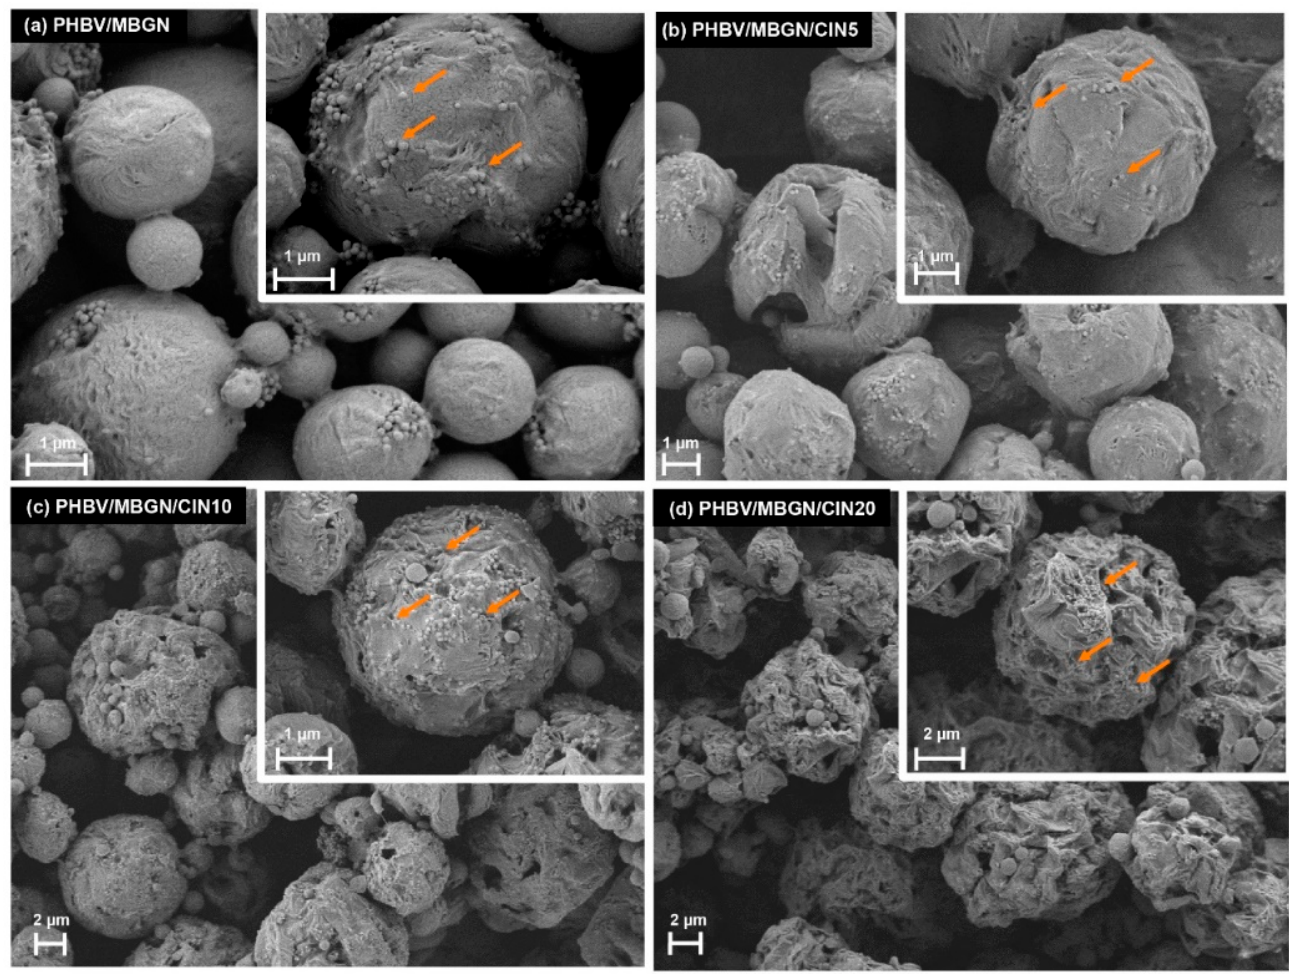
Figure 1. Scanning electron micrographs of ( a ) PHBV/MBGN; ( b ) PHBV/MBGN/CIN5; ( c ) PHBV/MBGN/CIN10, and ( d ) PHBV/MBGN/CIN20 microspheres. Arrows indicate mesoporous bioactive glass nanoparticles.